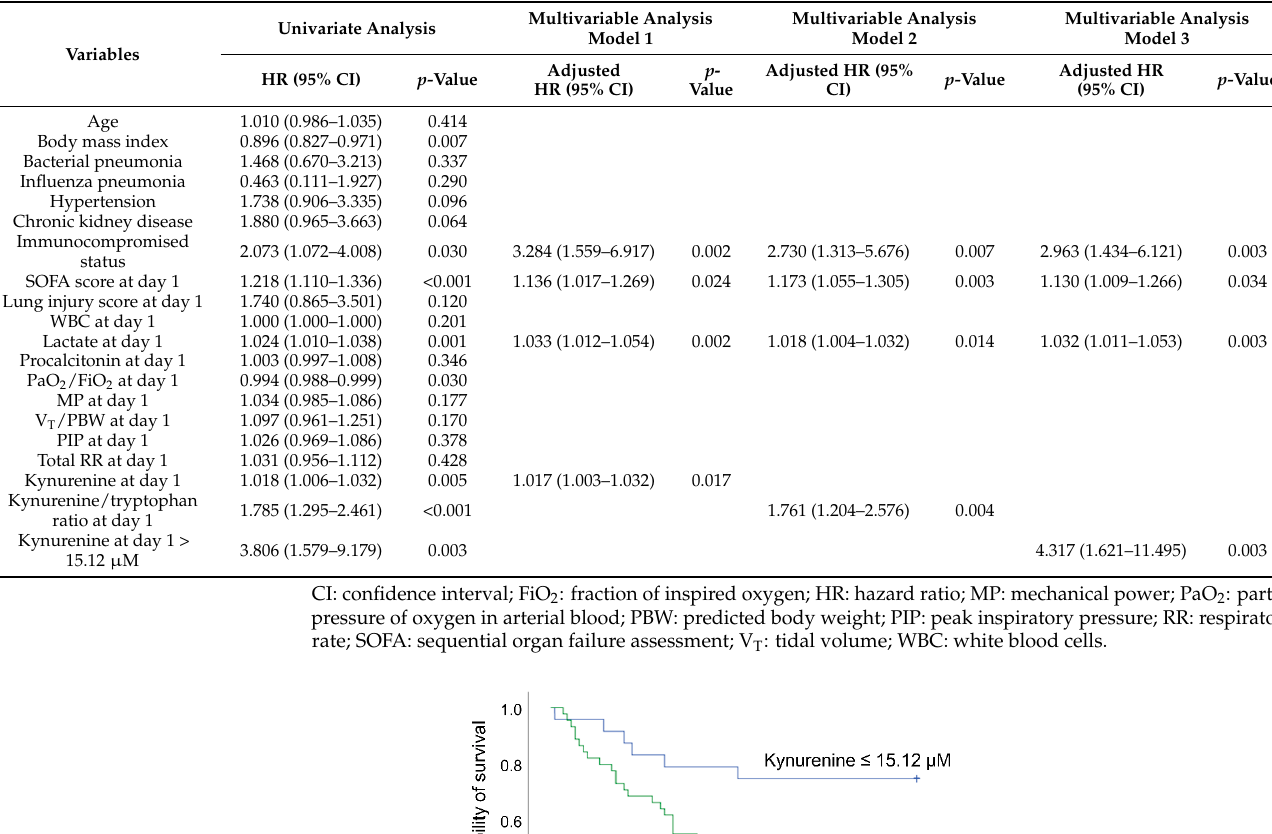
Table 4. Cox proportional hazard regression analysis of factors associated with hospital mortality.